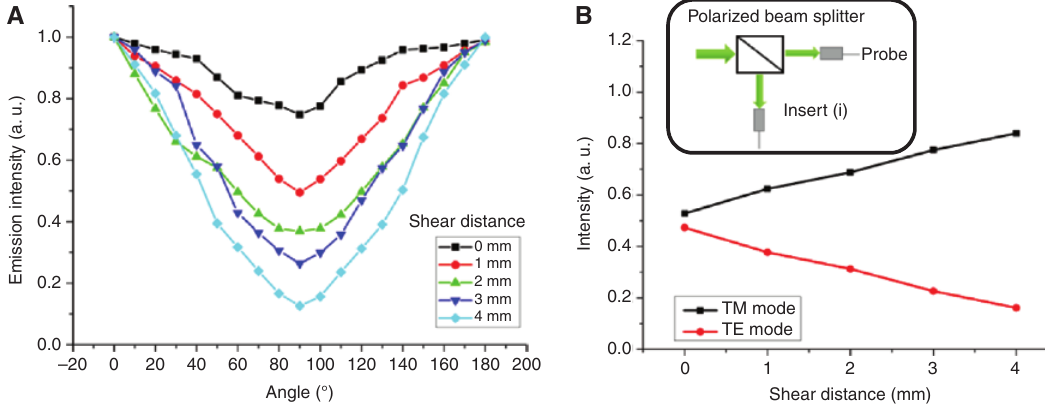
Figure 4: The relationship between emission intensity and shear distance. (A) The normalized Intensity of random laser depends on the rotation angle ϕ . (B) The dependence of proportion of TM mode and TE mode on shear distance. Insert (i). The sketch for measuring TM and TE mode beams.